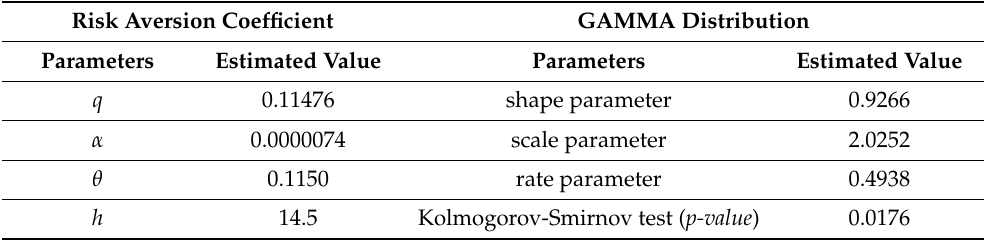
Figure 3. Probability density plot and its GAMMA distribution probability density fitting curve. Table 3. Estimation results.